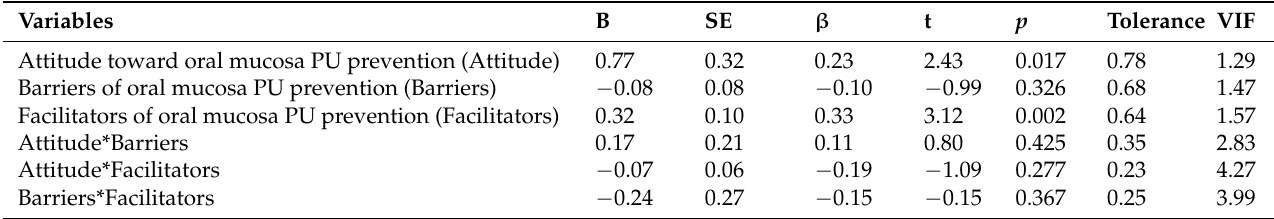
Table 5. Multiple regression on intention for performing oral mucosa PU care (N = 112).